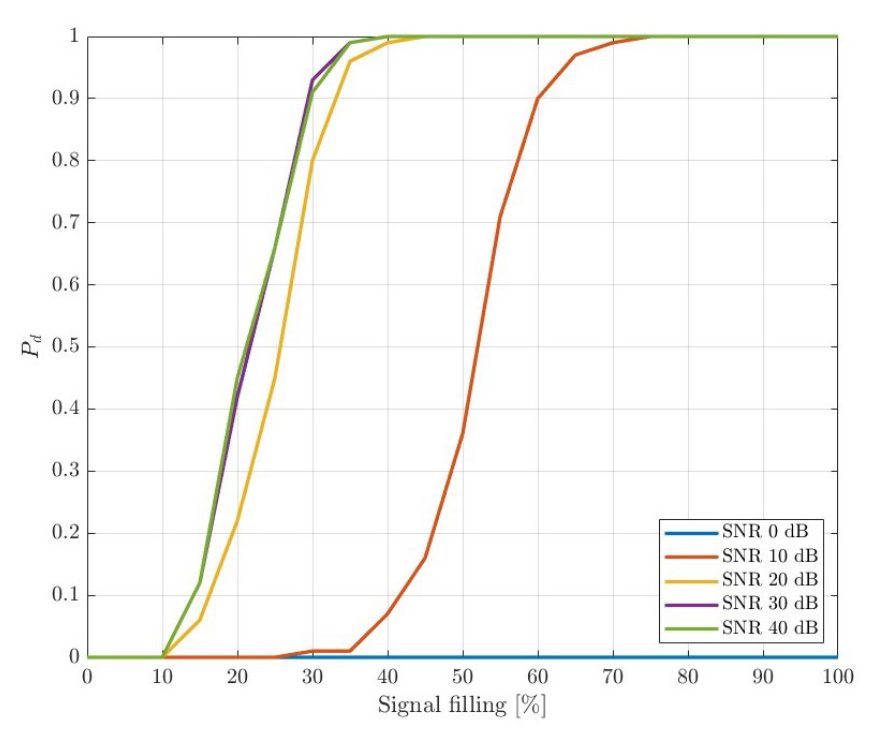
Figure 16. Probability of detection as a function of signal filling, P fa = 10 − 6